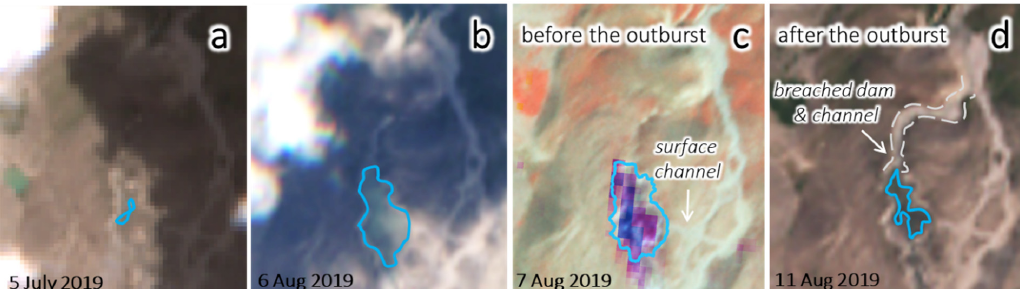
Figure 2. Perimeter of the Toguz-Bulak glacial lake during July–August 2019. ( a , b ) Image data from the Sentinel-2 satellite taken on ( a ) 5 July and ( b ) 6 August. ( c ) Lake margin data from the Landsat8/OLI satellite taken on 7 August. ( d ) Image data from the Sentinel-2 satellite taken on 11 August. Blue lines are outline of the lake.